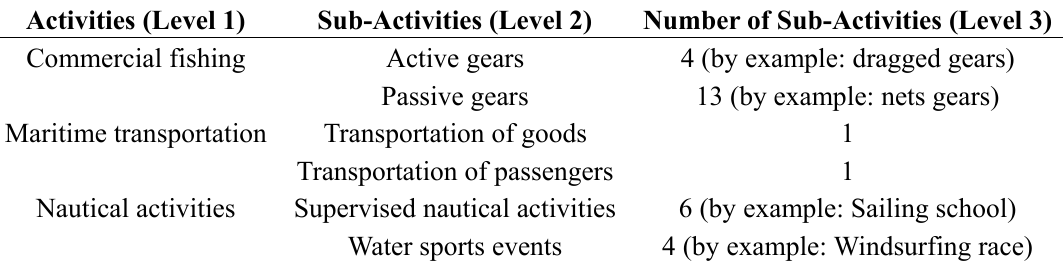
Table 1. Supervised maritime activities in the Bay of